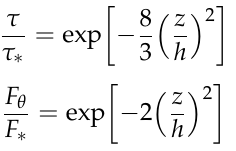
Figure 3. Dependence of the momentum flux on the Reynolds averaging scale 𝐿 used to compute the perturbation quantities for ( a ) stationary and ( b ) nonstationary episodes. perturbation quantities for ( a ) stationary and ( b ) nonstationary